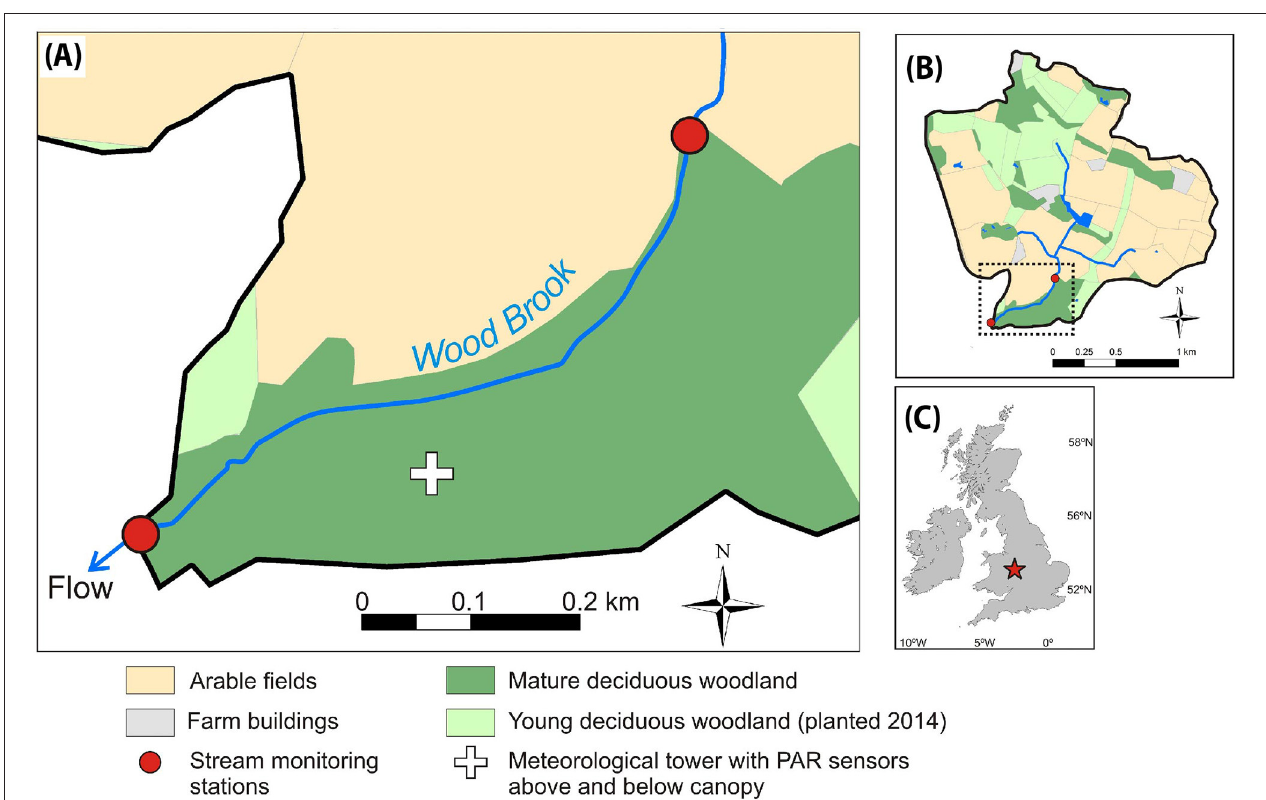
FIGURE 1 | Map of monitoring location showing (A) the study reach, (B) the stream catchment, and (C) location of the site in the